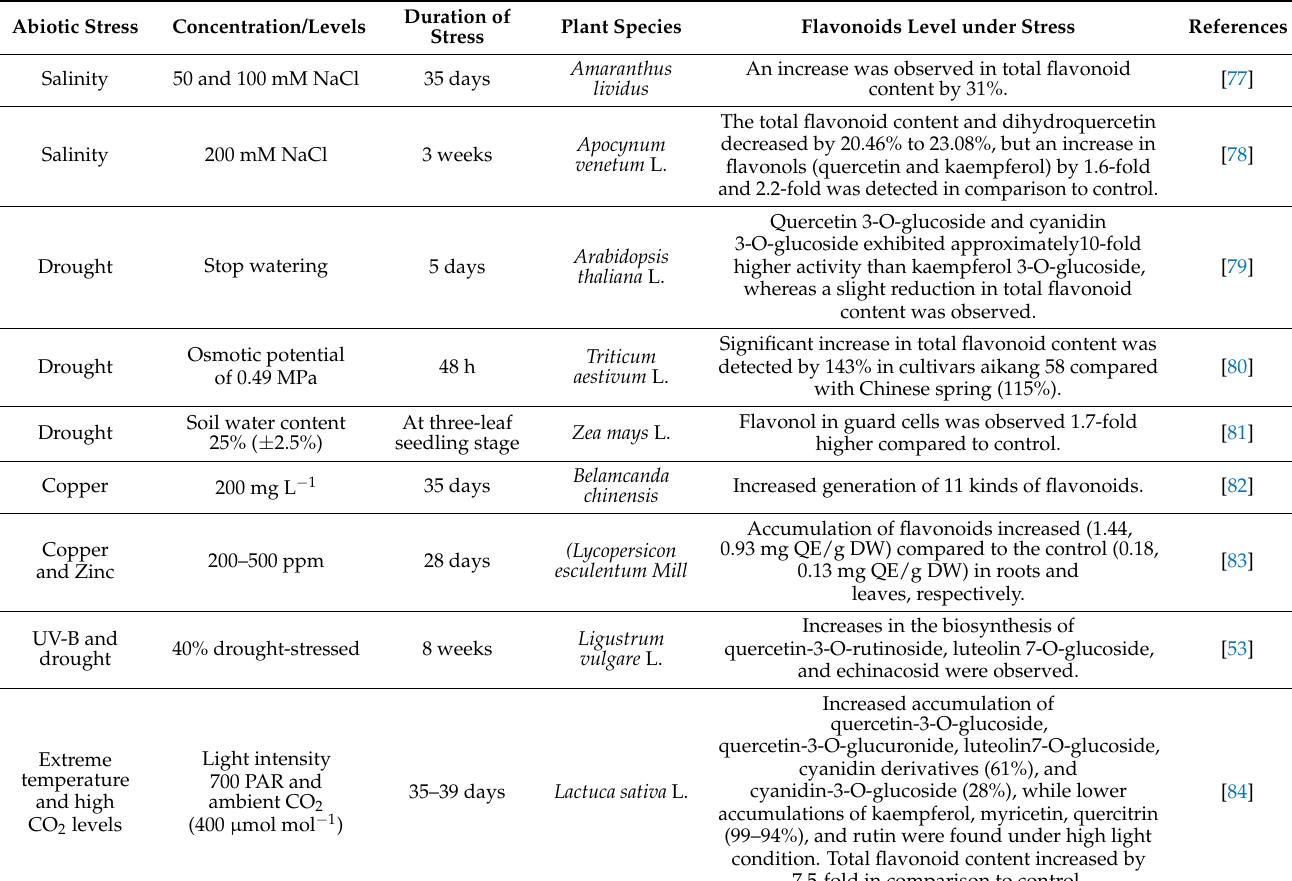
Table 2. Differential response of flavonoids under different abiotic stress.